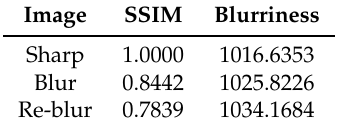
Table 2. Blurriness of four sets of images shown in Figure 6, demonstrating the consistency between the proposed image blurriness metric and DMOS, i.e., the subjective scores given by the datasets. CSIQ LIVE II IVC TID2013 DMOS Blurriness DMOS Blurriness DMOS Blurriness DMOS